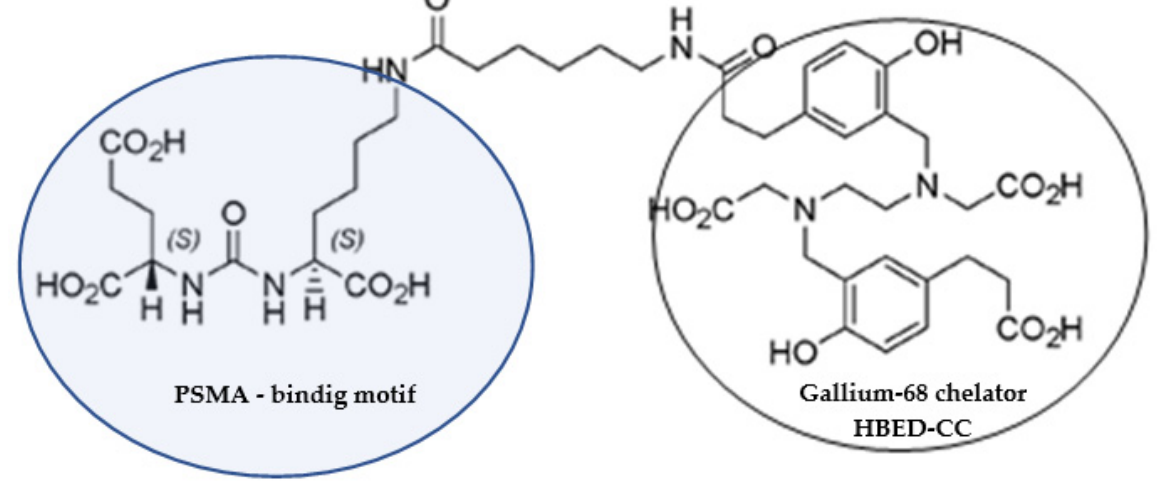
Figure 1. Chemical structure of PSMA-11.